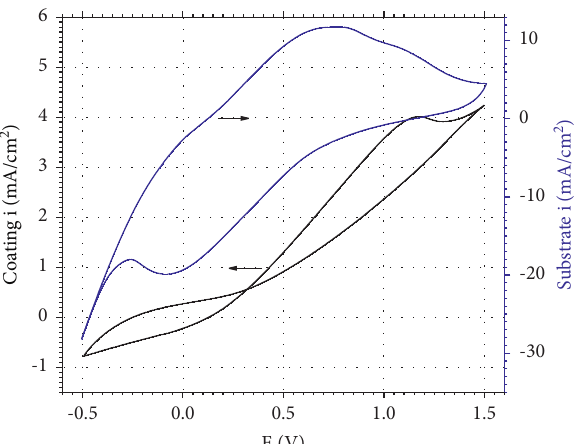
2 -Sb 2 O 3 (black curve) electrodes in solution